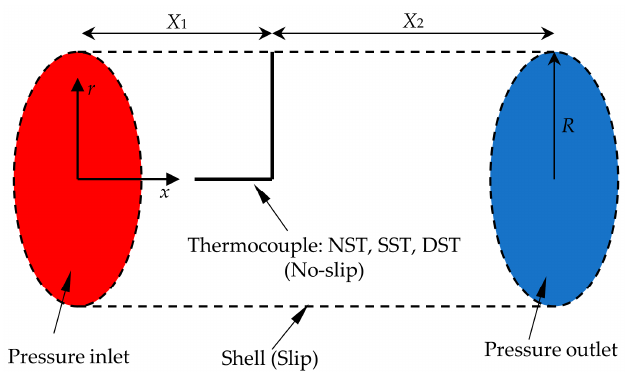
Figure 3. Schematic of the computation domain and boundary conditions. The thermocouple was replaced by an L-shaped structure with the three structures shown in Figure 2 at the end.